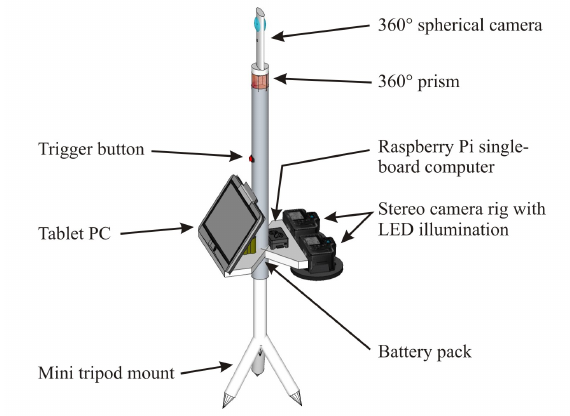
Figure 1: The “walking stick” scanner and its main components: A stereo-rig with custom LED illumination, a microcontroller based control unit, a tablet PC, a button to trigger one scan, a 360 ◦ prism for outside-in tracking by a tachymeter, and a spheri- cal camera for inside-out verification of scanner pose.